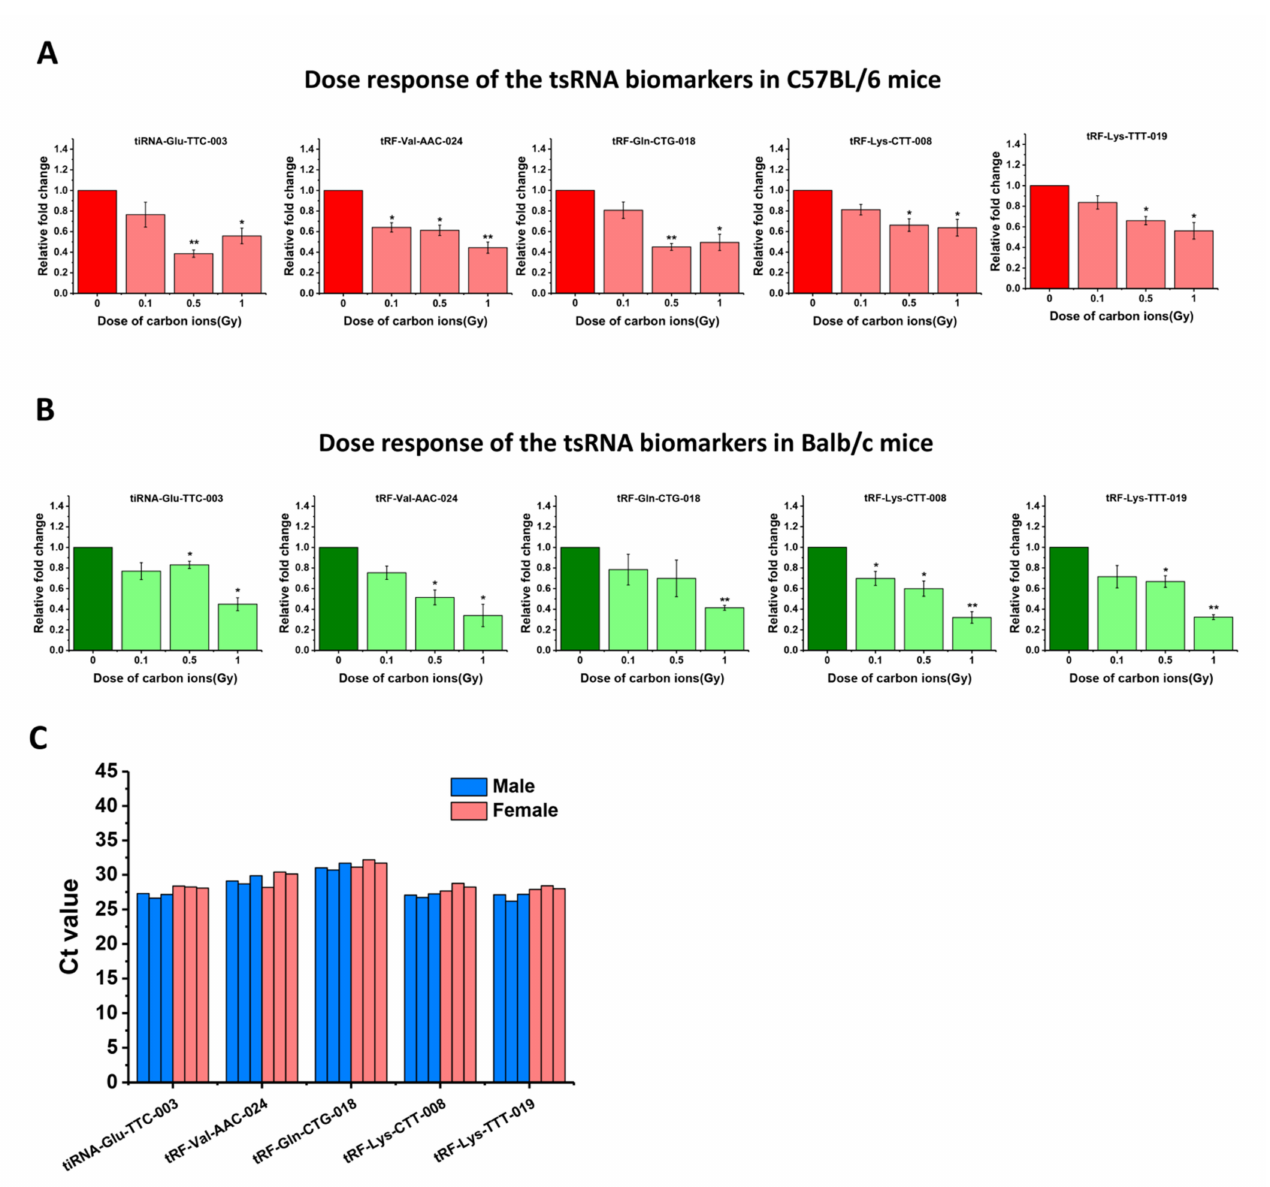
Figure 6. The radiation responses of the five tsRNA biomarkers in different mice species and their expression levels in human serum. ( A ) The relative expression of the five tsRNAs responding to carbon ion irradiation in C57BL/6 mice. ( B ) The relative expression of the five tsRNAs responding to carbon ion irradiation in Balb/c mice. * p < 0.05, ** p < 0.01, compared with control group (0 Gy). ( C ) The expression of five tsRNA biomarkers in serum sample of six healthy humans (200 µ L/sample) was detected by RT-qPCR. The Ct value of the five tsRNAs in each sample is as